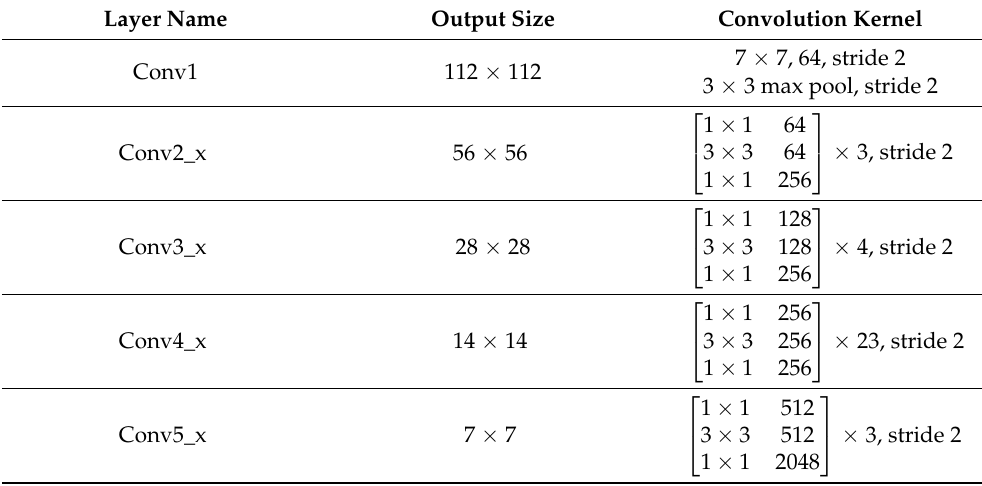
Table 3. ResNet-101 network architecture.